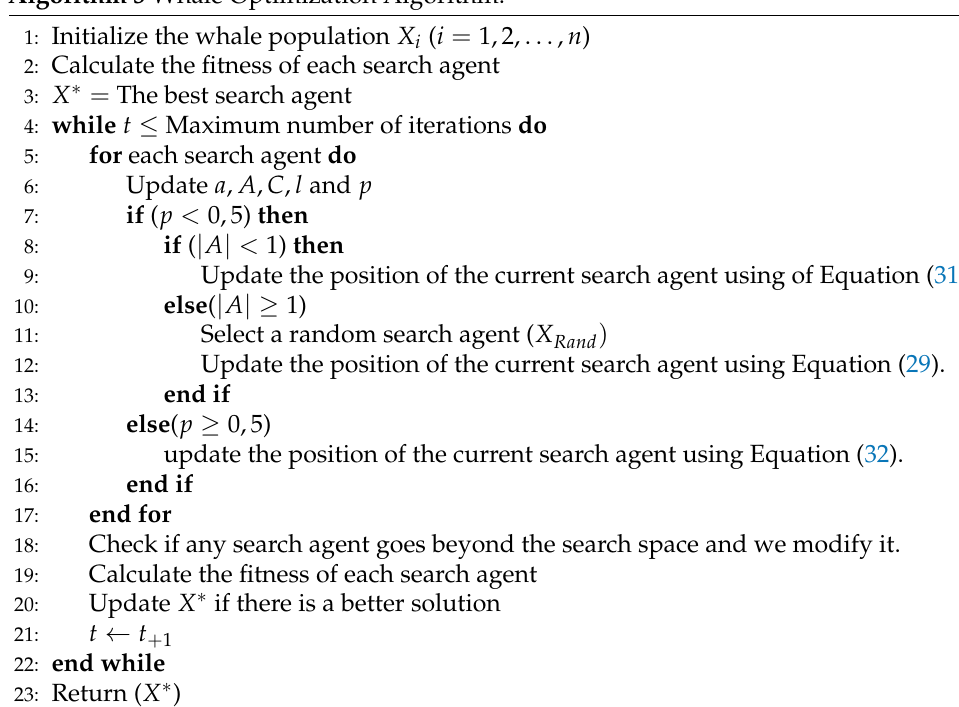
Algorithm 3 Whale Optimization